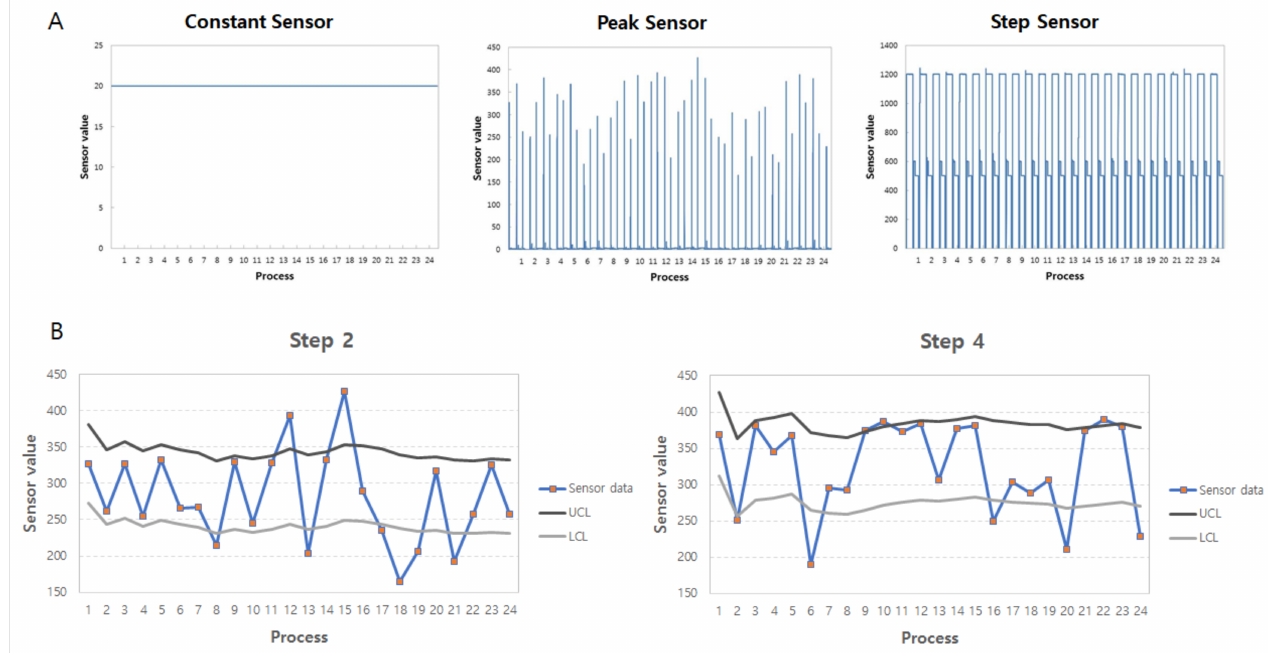
Figure 2. Individual inspection for the sensor stabilization. ( A ) Classification of sensors. The sensor data were comprised of three types according to their output shape: constant, peak, and step sensor. ( B ) Outlier detection from the preprocessed data of a peak sensor (V009). The highest peak values were extracted at each step of the process. Since the peak of the V009 sensor appeared twice, the peak values were extracted at steps 2 and 4,